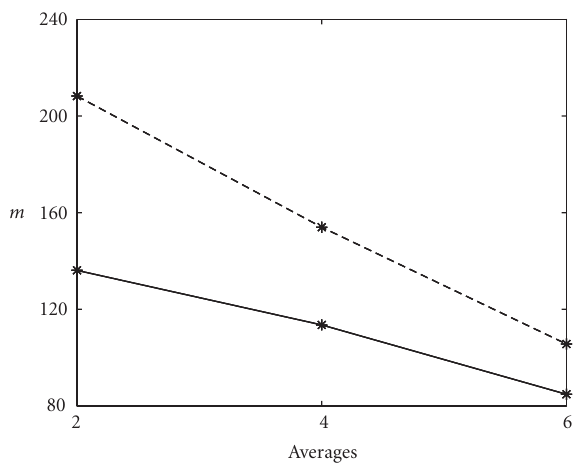
Figure 6: Comparison of m ( D , D ∗ ) for the original tensors (dashed) and the regularized tensors (solid) versus the number of averaged acquisitions.